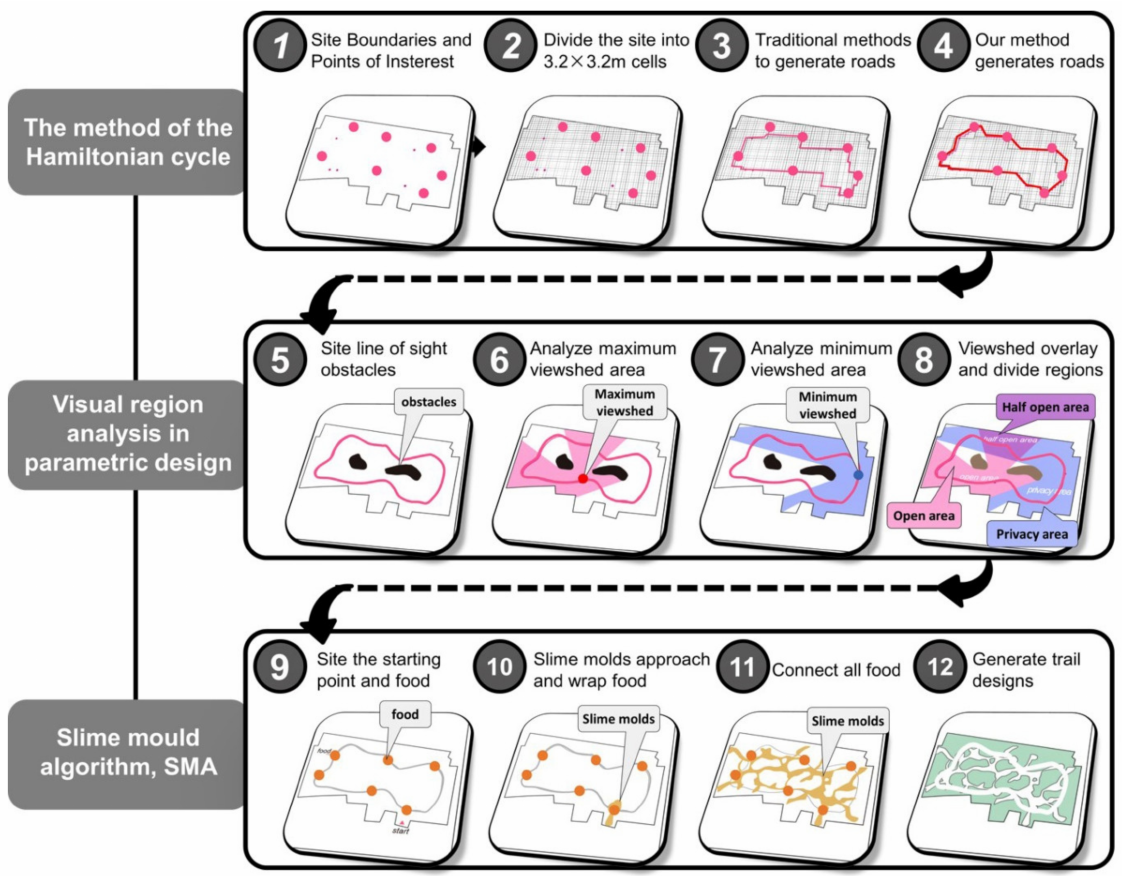
Figure 12. Design method and process (4) For the embodiment of the historical dimension of Jiangnan classical gardens, the genetic algorithm method is mainly used in parametric design. As seen in the prototype of the scheme generated in the process described above, the curvature and viewshed values obtained from the analysis are incorporated into the genetic algorithm to further optimize the path. At the same time, it is also necessary to control the density of the road network and appropriately increase or decrease the length of the path to meet the requirements of the design specifications. The curvature and field of view are obtained from the statistics of the existing Jiangnan classical gardens, and are also very important components of the Jiangnan classical gardens. The relevant laws have continued to exist throughout history, and the new scheme conforms to them, reflecting the historical dimension of the